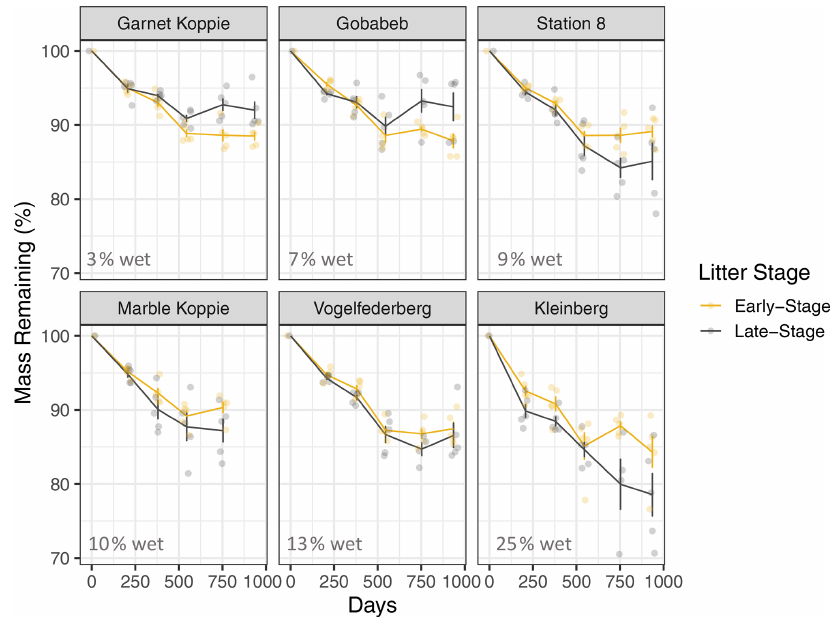
Figure 3. Mass loss for early-stage (yellow) and late-stage (gray) tillers at each site (mean ± 1S.E.M.). Percentage values in the bottom of each panel show the average proportion of time throughout the study period that the site has liquid water, as determined by a leaf wetness sensor. Note: tillers did not actually increase in mass; the apparent increase at some time points in some panels is merely a result of variation among tillers, since we destructively harvested tillers at each time point and could therefore not take repeated measurements of each